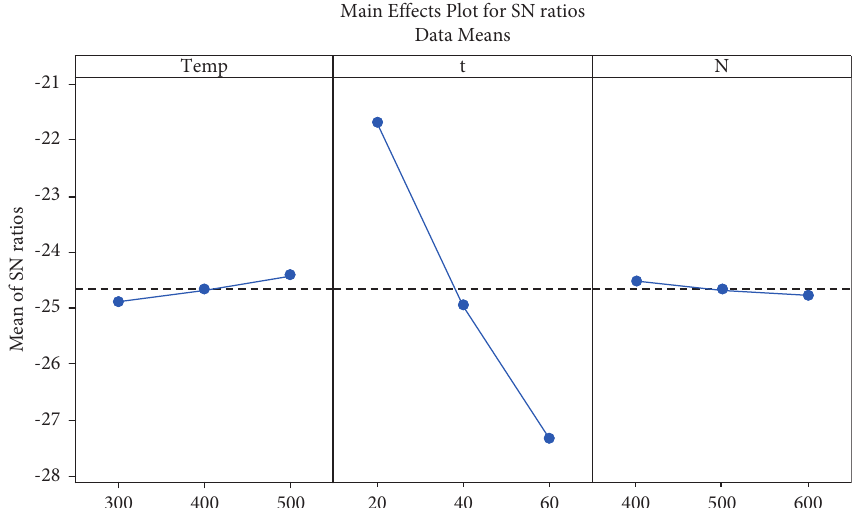
Figure 2: Significant consequence diagram based on the SN ratio for porosity (temp: temperature in ° C; t: time in sec; and N : stir speed in rpm).